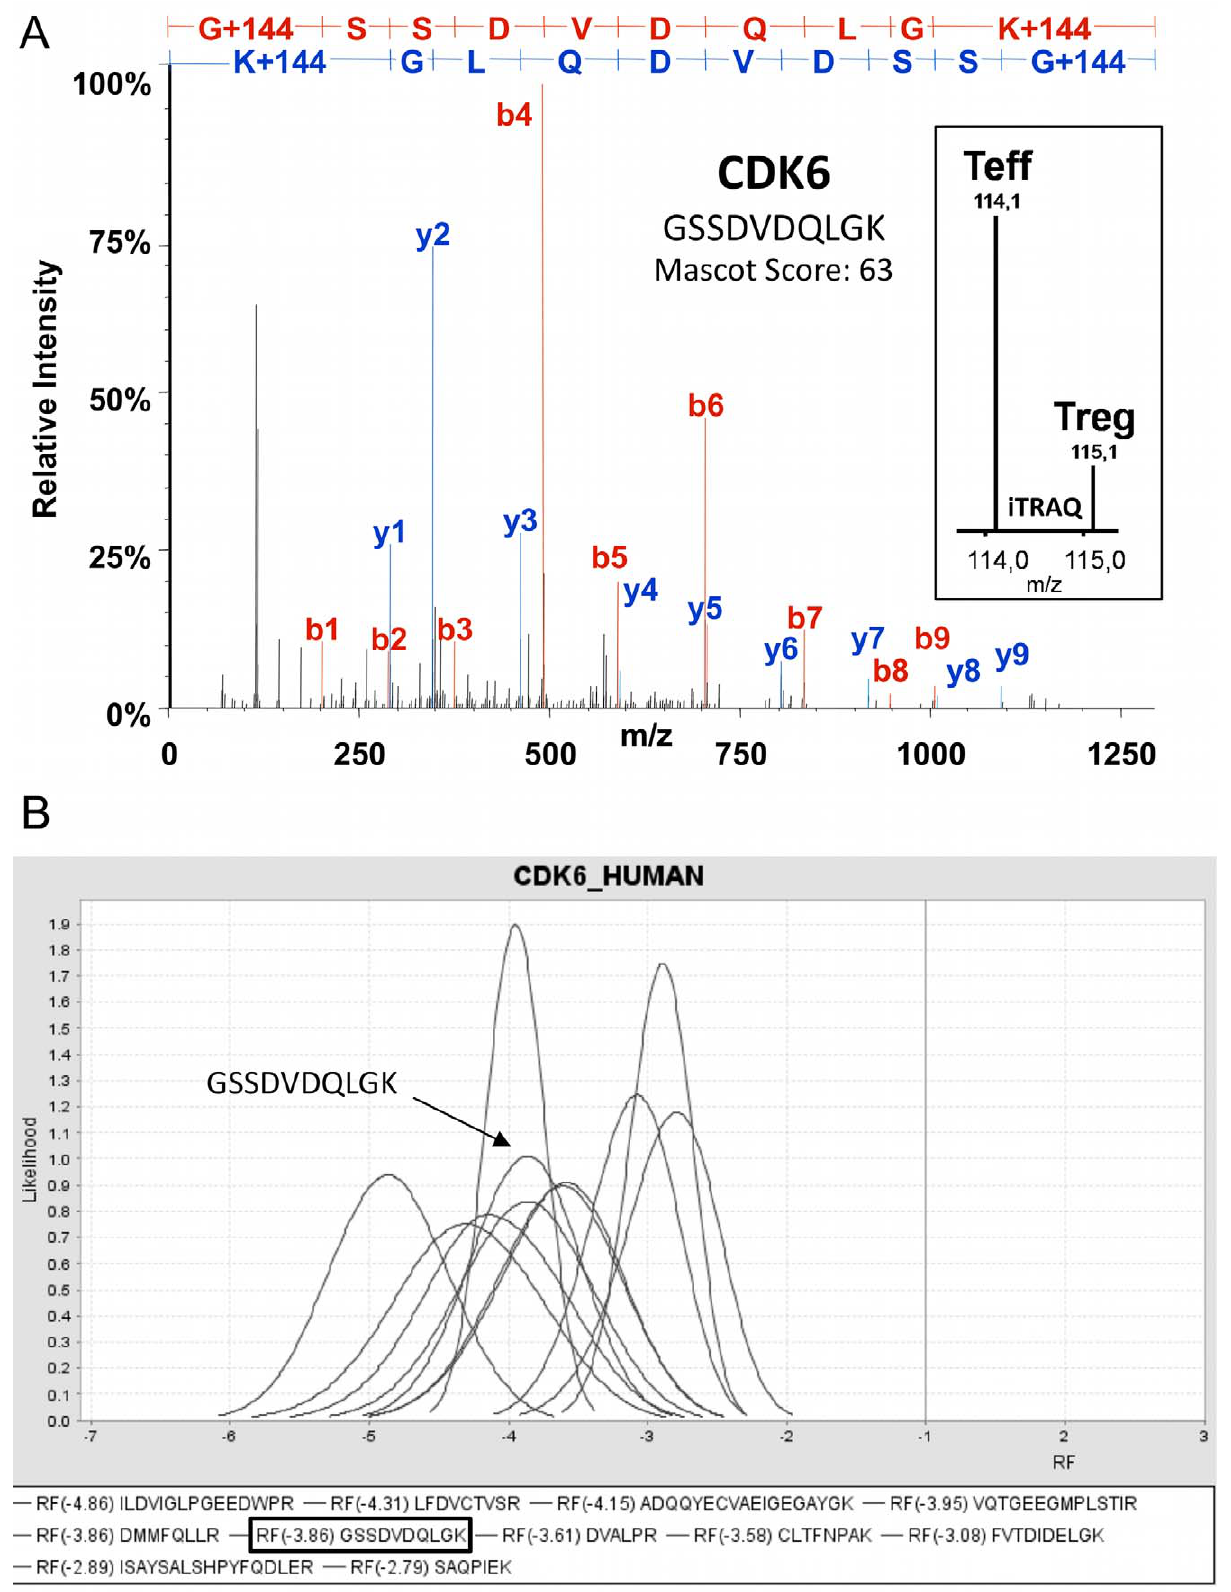
Figure 4. iTRAQ-based quantification and statistical evaluation of relative kinase expression in Tregs and Teffs. iTRAQ-based quantification and statistical analysis of differential kinase expression in Tregs and Teffs is exemplarily shown using the example of cyclin-dependent